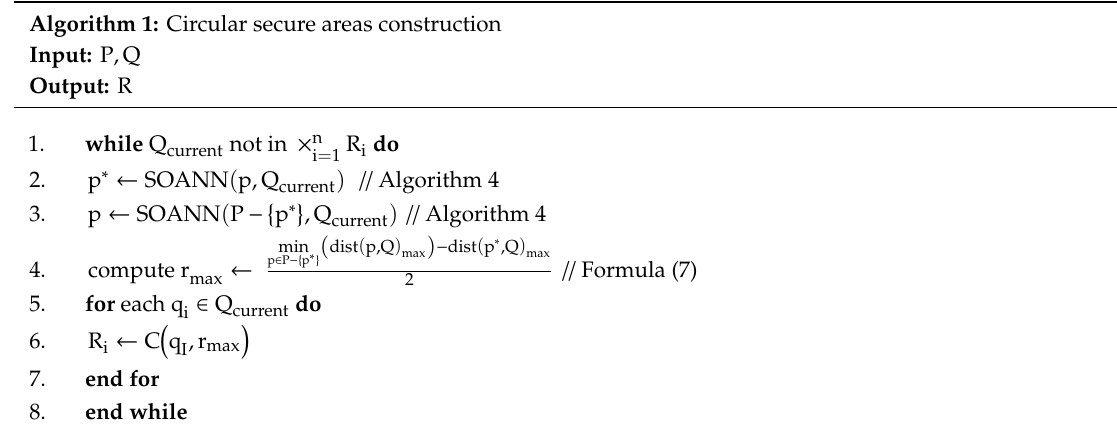
Algorithm 1: Circular secure areas